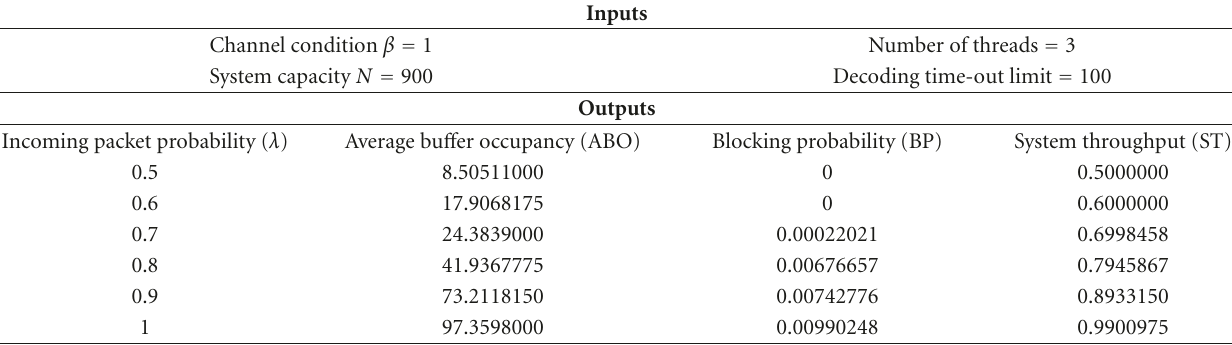
Table 2: Average bu ff er occupancy, blocking probability, and system throughput ( β = 1 . 0, T =